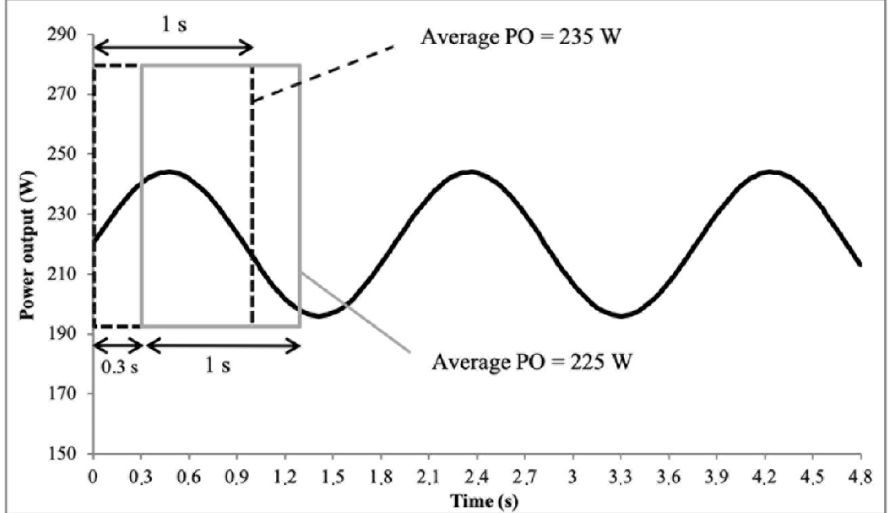
Figure 3. Representation of power output (PO) values with two different periods of 1 s shifted by 0.3 s.